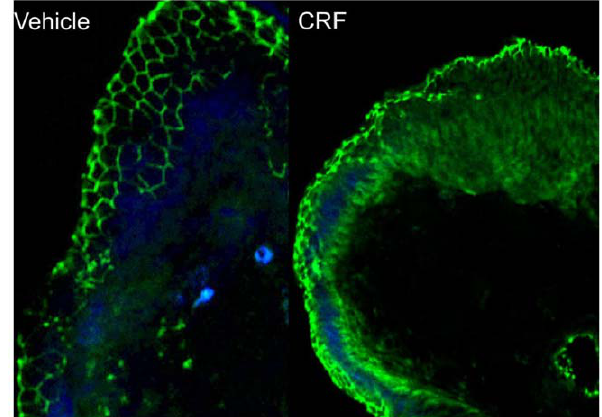
Figure 4. Occludin localization in porcine ileum exposed to CRF. In control (vehicle-treated) tissues (A), occludin (green) was localized predominantly to the interepithelial tight junctions as demonstrated by the epithelial membrane staining patterns whereas CRF-treated tissues (B) exhibited a disrupted occluding staining pattern. Images are representative of tissues from n=3 pigs.